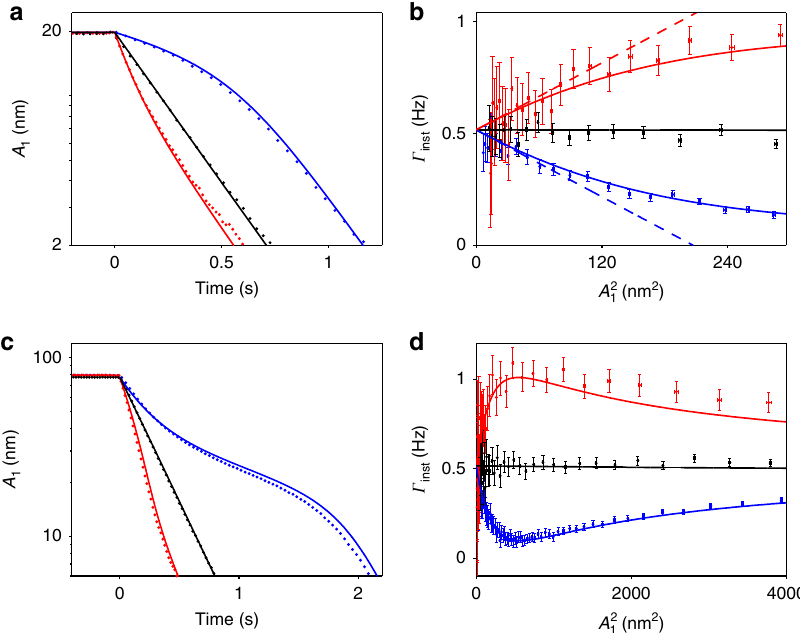
Fig. 2 Positive and negative nonlinear friction on the plate mode due to two-phonon processes. a Measured (dots) and calculated (lines) ringdown of the dimensional vibration amplitude A 1 of mode 1 with no sideband pumping (black) and pumping at the red-/blue-detuned secondary sideband (red/blue) that leads to positive/negative nonlinear friction; Δ = − 35 Hz. b The instantaneous decay rate as a function of the squared vibration amplitude. Dashed lines are from Eq. (6), solid lines show the extended adiabatic theory (Supplementary Note 2). c , d Similar plots as ( a ) and ( b ), for larger initial vibration amplitude. Error bars represent ±1